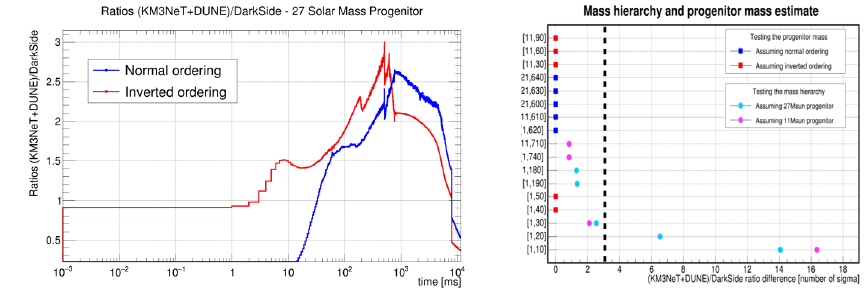
, computed in 1 ms bins, as a function of time for a 27 M R between models for di ff erent time windows. R